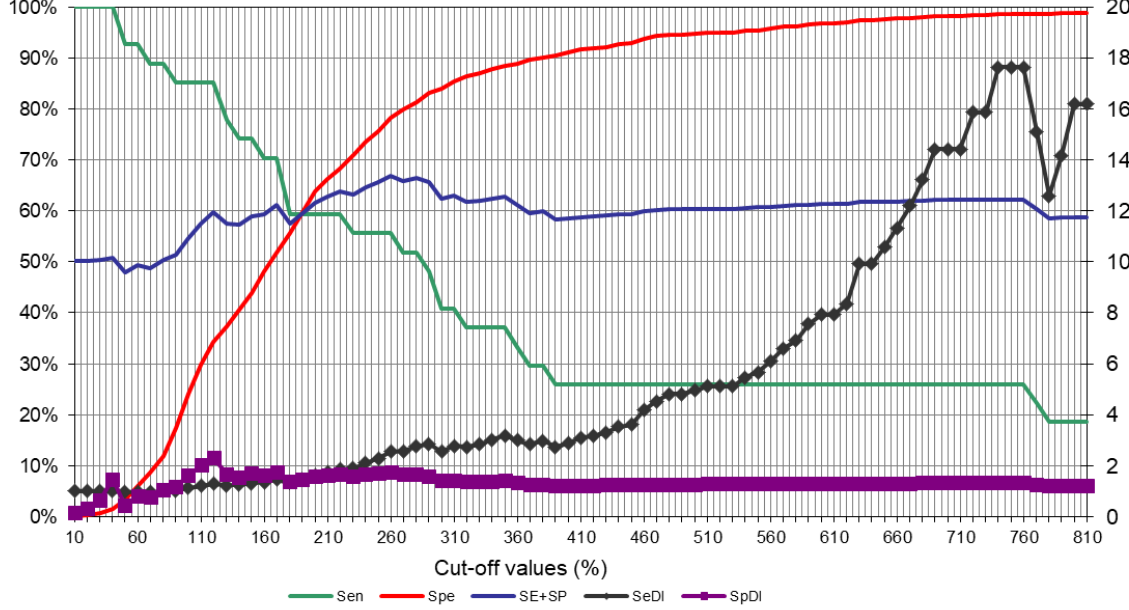
Figure 1. Definition of the P22 ELISA cut-off against a Mycobacterium tuberculosis complex (MTC) isolation reference. The graph includes data sera from positive and negative animals to bacteriological culture, as well as both trapped and road-killed animals. Sen: sensitivity; Spe: specificity; SE + SP: semi-sum or diagnostic value of sensitivity and specificity; SeDI: sensitivity discriminatory index (ratio of sensitivity to 1-specificity); SpDI: specificity discriminatory index (ratio of specificity to 1-sensitivity).